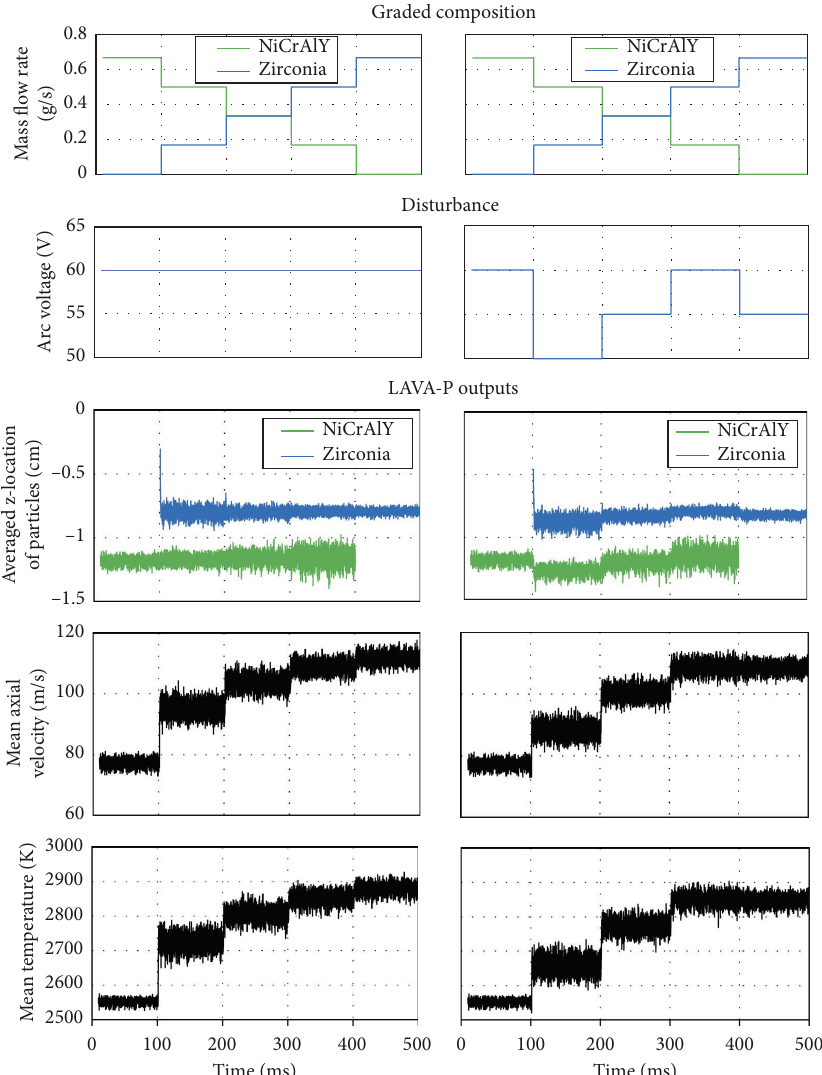
Figure 11: For the two desired graded compositions of the coating exhibited in row 1 and without using a controller, the efect of disturbances in the arc voltage is shown in row 2 on the averaged z-locations of NiCrAlY and ZrO 2 particles depicted in row 3 and their MPSs shown in rows 4 and